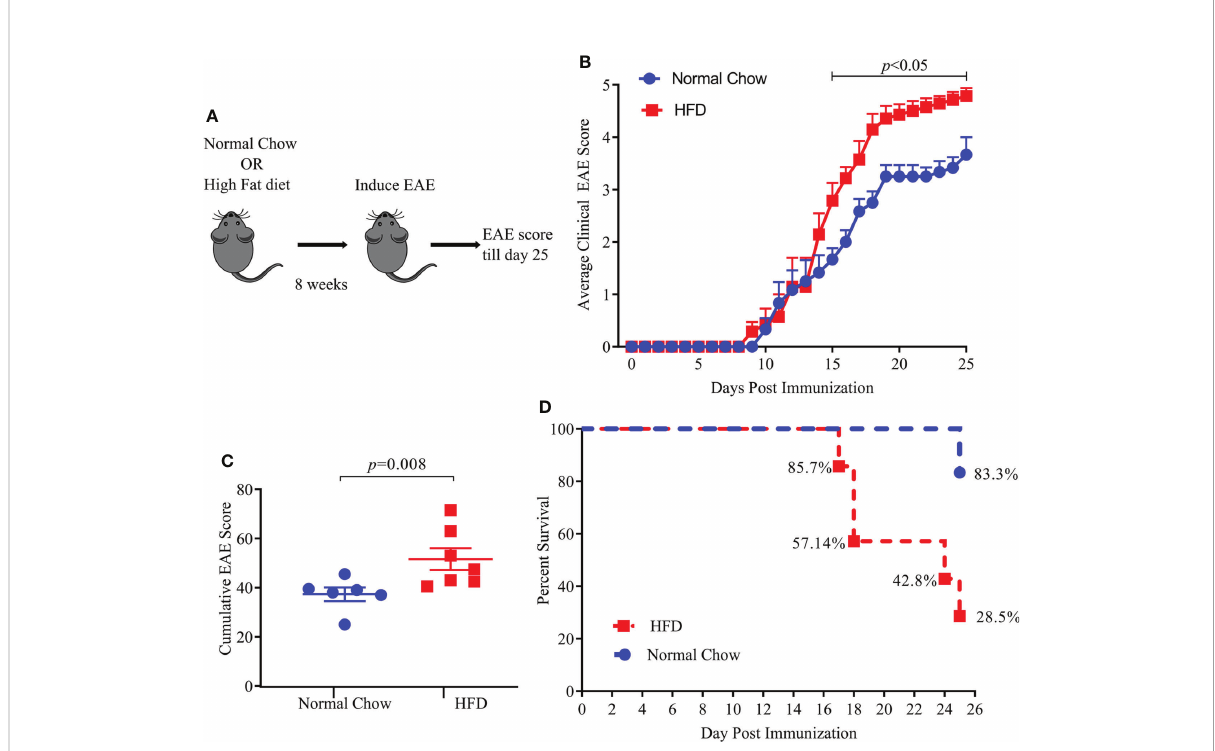
FIGURE 1 High fat diet (HFD) increases EAE severity in HLA-DR3 transgenic mice. (A) Model diagram representing day of diet initiation, EAE induction and disease scoring in HLA-DR3 transgenic mice. 6-8 weeks old HLA-DR3 transgenic mice were kept on Normal Chow (n= 6) and HFD (n= 7) for eight weeks. Mice were immunized with PLP 91-110 /CFA and pertussis toxin at days 0 and 2 to induce EAE. Mice were monitored for EAE disease progression before euthanizing on day 25 post-immunization. (B) Average clinical EAE scores from mice in A, acquired over time. (C) Cumulative EAE scores from mice in A. (D) Percent survival of mice in (A) , Data are representative of 3 independent experiments with 3-5 mice per group. Error bars represent the standard error of the mean for each experimental group. p -value was determined by 2-way ANOVA Sidak multiple comparisons test (B) , and Mann-Whitney test between the experimental groups (C)